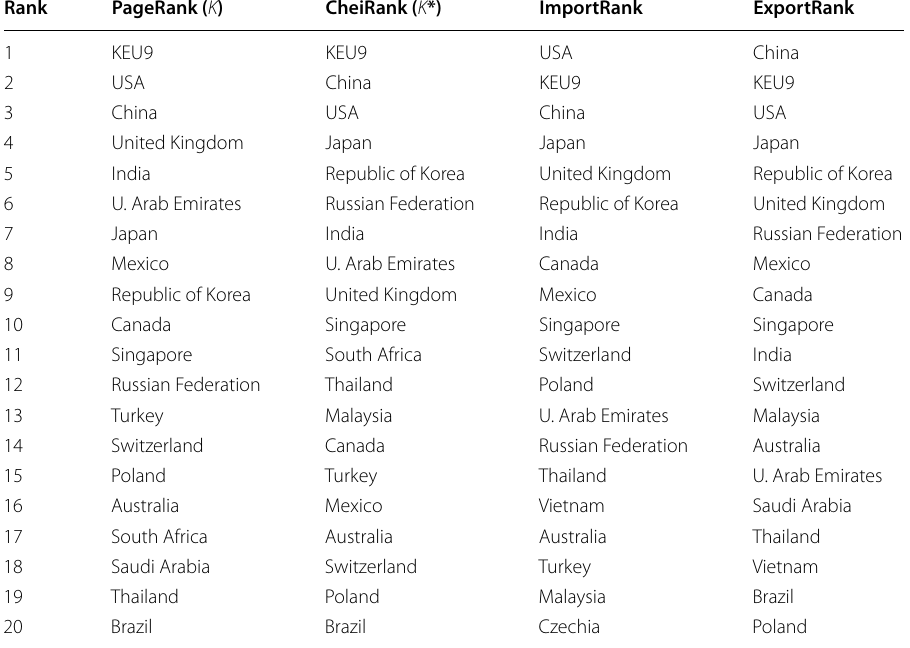
The table lists country ranks of both panels of Fig. 1